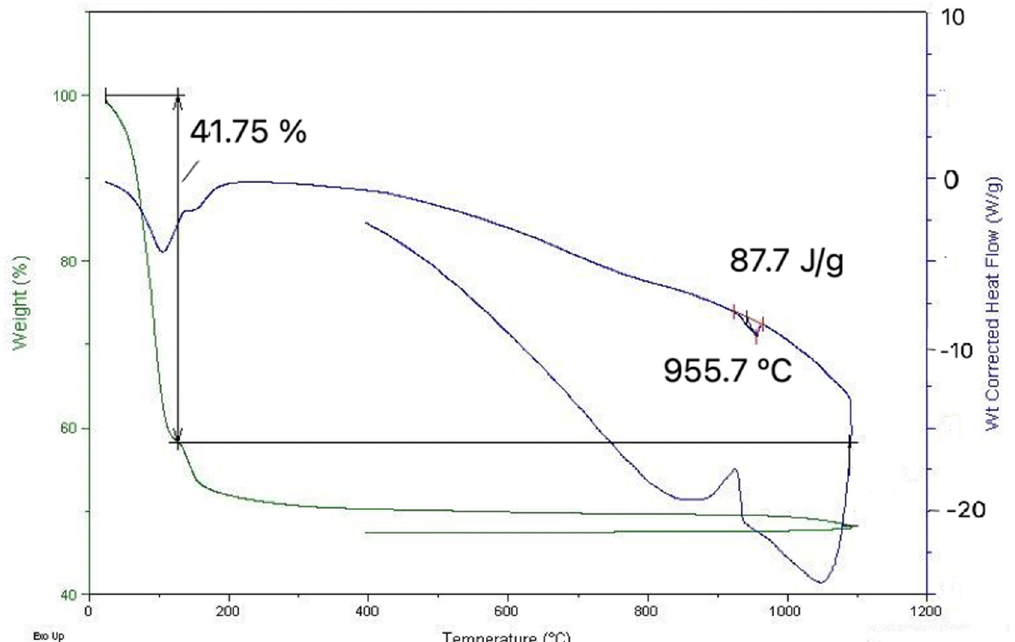
Figure 9. DTA/TGA graph.